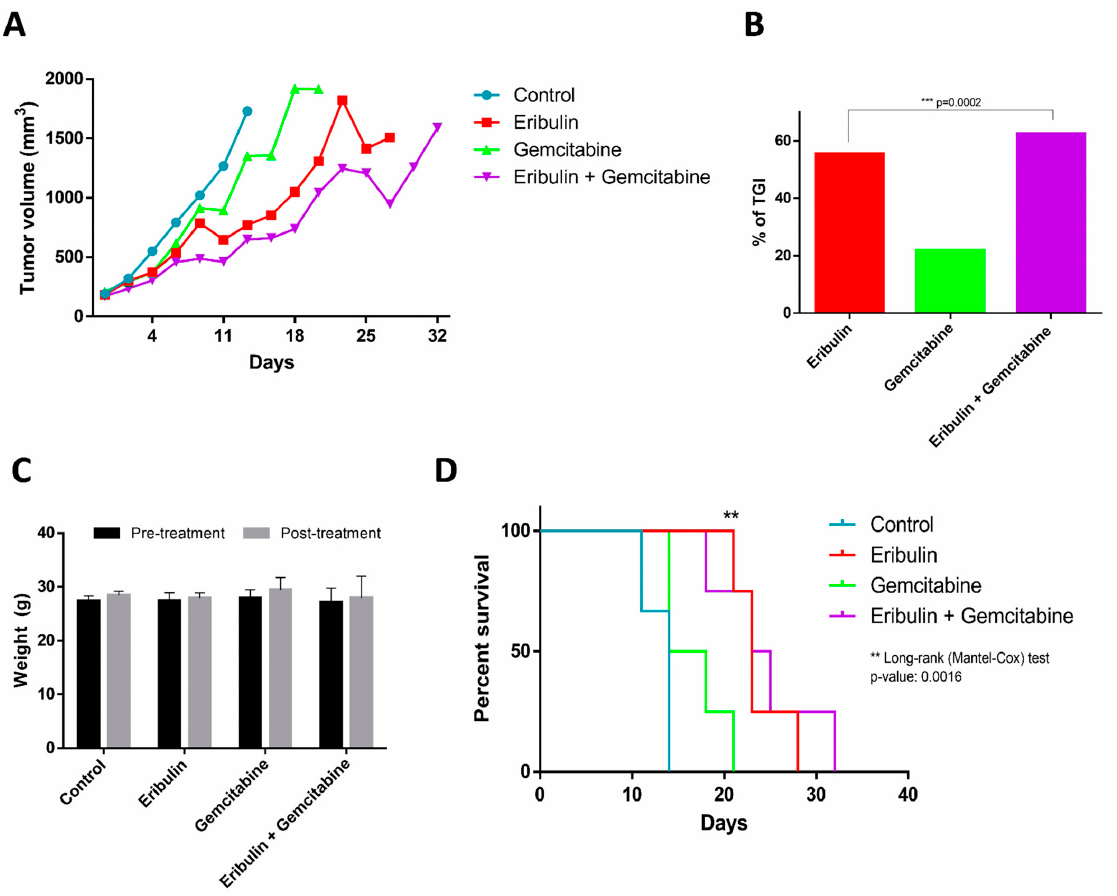
Figure 4. Effect of the combination of eribulin and gemcitabine in vivo in the PDX model LMS-IBiS- 002. ( A ) Tumour volume, expressed in mm 3 , of mice subjected to each of the treatments: control (blue; n = 3), eribulin in monotherapy (red; n = 4), gemcitabine in monotherapy (green; n = 4) and eribulin + gemcitabine (purple; n = 4). Mice were sacrificed when they reached the volume of 1500 mm 3 . ( B ) Percentage inhibition of tumour growth with respect to the control group calculated on day 14 of treatment. Wilcoxon test for paired samples: *** p < 0.0005. ( C ) Weight, expressed in grams, of each experimental group before and after treatment with each of the drugs ( D ) Kaplan–Meier curve representing the survival probability of the different treatment groups. Log-rank test (Cox Mantel): ** p < 0.005.